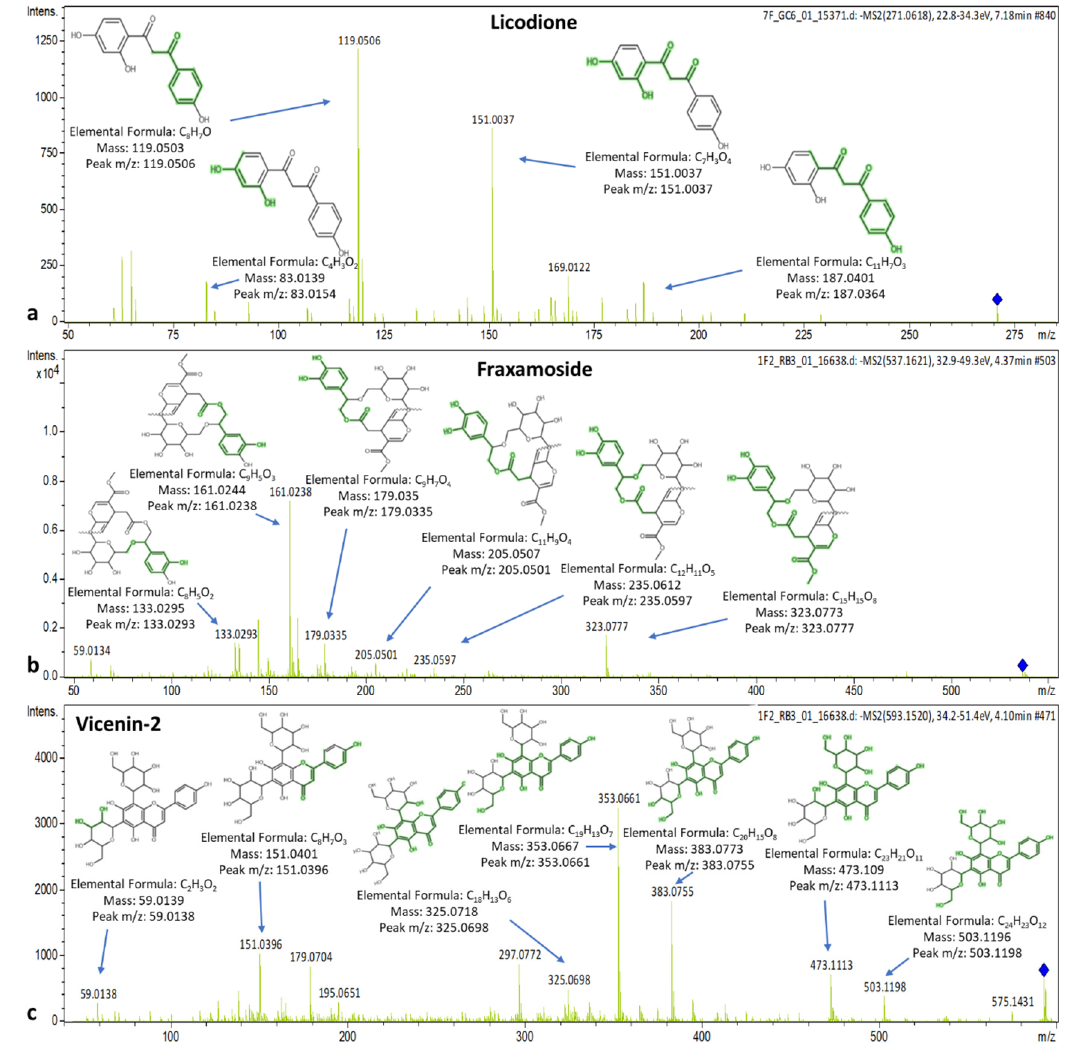
Figure 8. Spectra and MS/MS fragments of ( a ) licodione, ( b ) fraxamoside, and ( c ) vicenin-2.